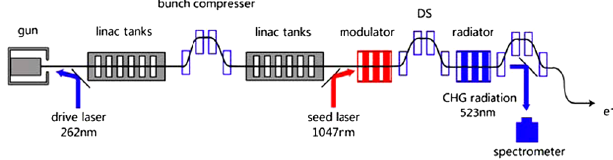
FIG. 6. Schematic layout of the SDUV-FEL scheme with CHG setup.